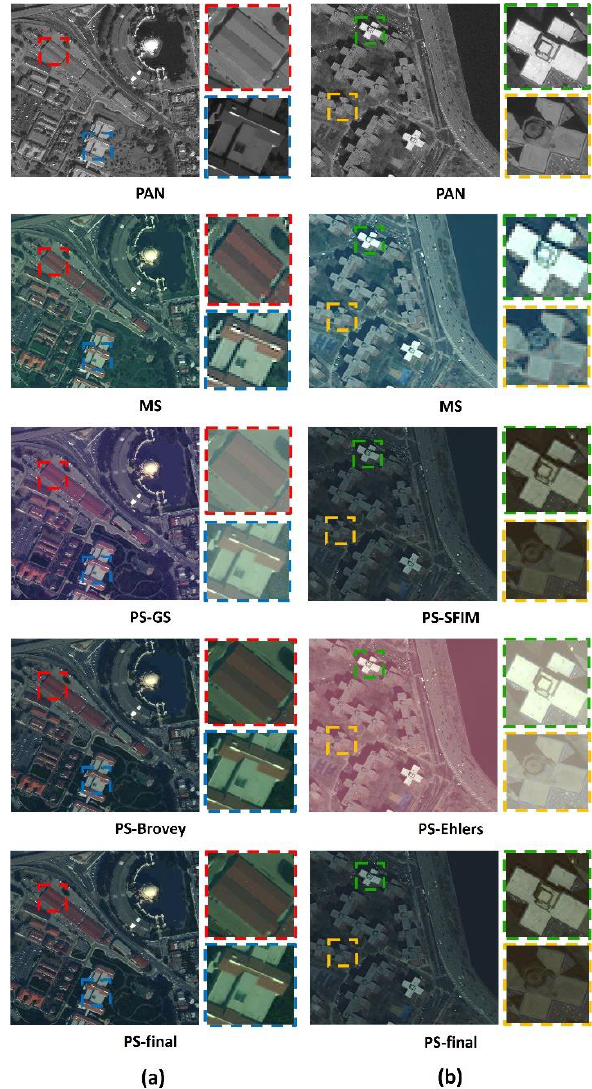
Figure 12. Subjective evaluation of final pan-sharpened images obtained by the decision-fusion method: (a) San Francisco dataset, (b) NY Figure 11. The final pan-sharpened images obtained by our decision-based fusion method: (a) San Francisco dataset, (b) NY dataset